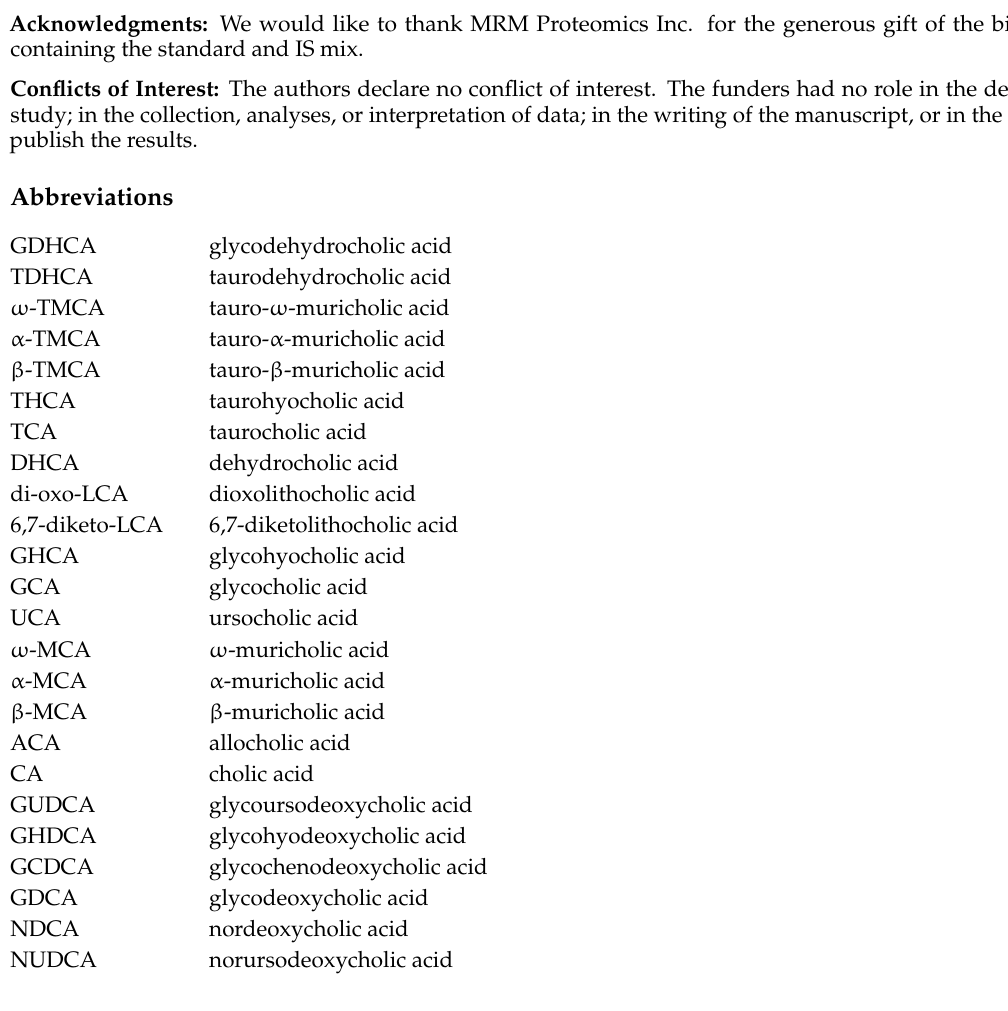
Table S1: Comparison of p-values and fold-changes between the four doses of APAP administered in this study (using two MRM transitions for each peak) of known bile acids showing significant di ff erences between the lowest and highest dose